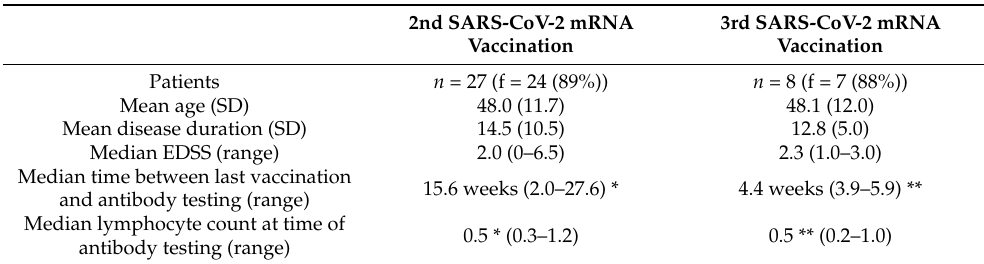
Table legend: f = female; SD = standard deviation; RRMS = relapsing-remitting MS; * median time between second vaccination and spike protein IgG testing, ** median time between third vaccination and spike protein IgG